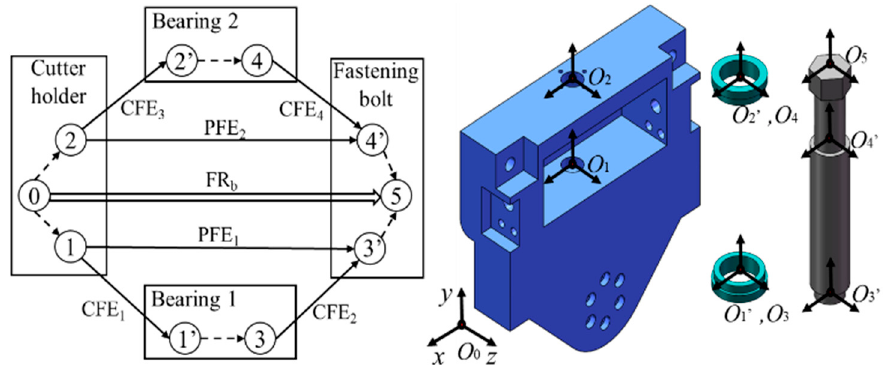
Figure 3. Dimensional chains of threaded fastening system.